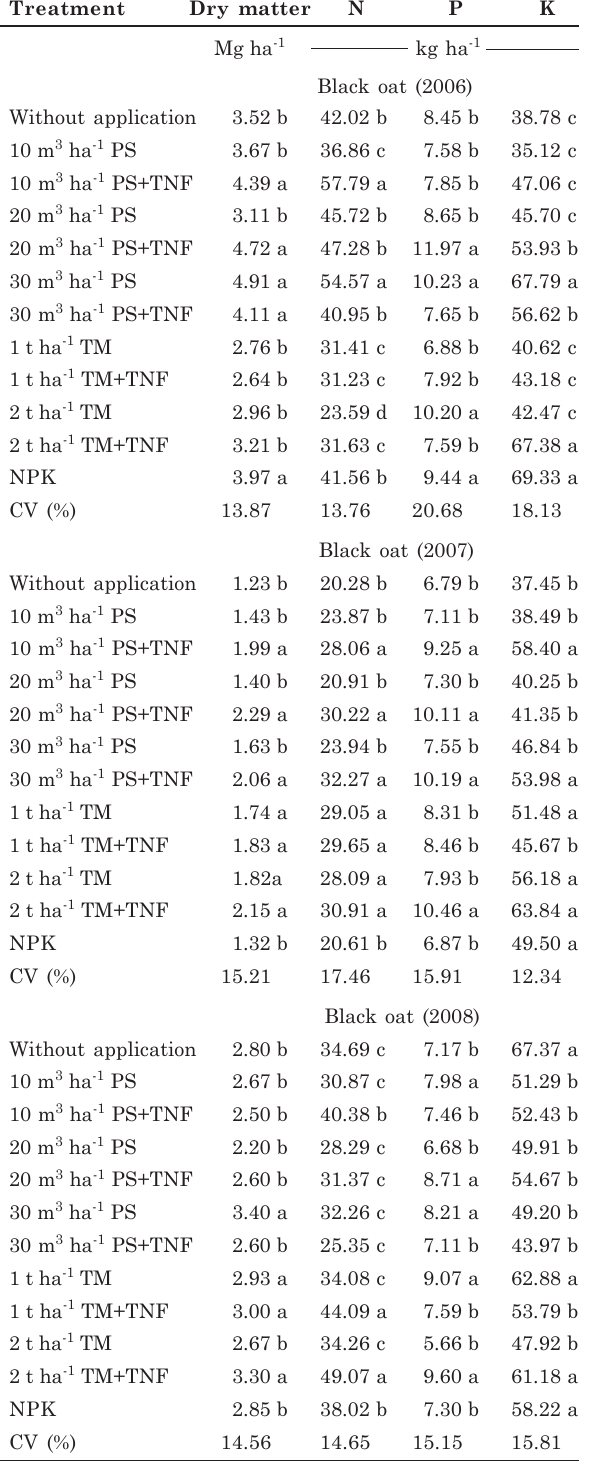
Table 4. Dry matter and nutrient accumulation in the aerial part of the black oat plants subjected to organic and mineral